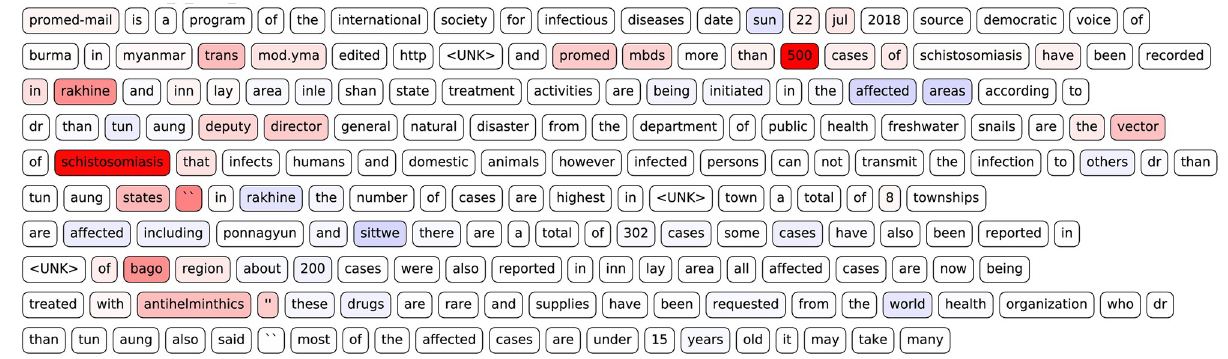
Fig 2. A layer-wise relevance propagation of the CNN for relevance classification. This text was correctly classified as relevant. Words that are highlighted in red contributed to the classification of the article being relevant and blue words contradicted this classification. The saturation of the color indicates the strength of which the single words contributed to the classification. <UNK> indicates a token for which no word embedding is available.